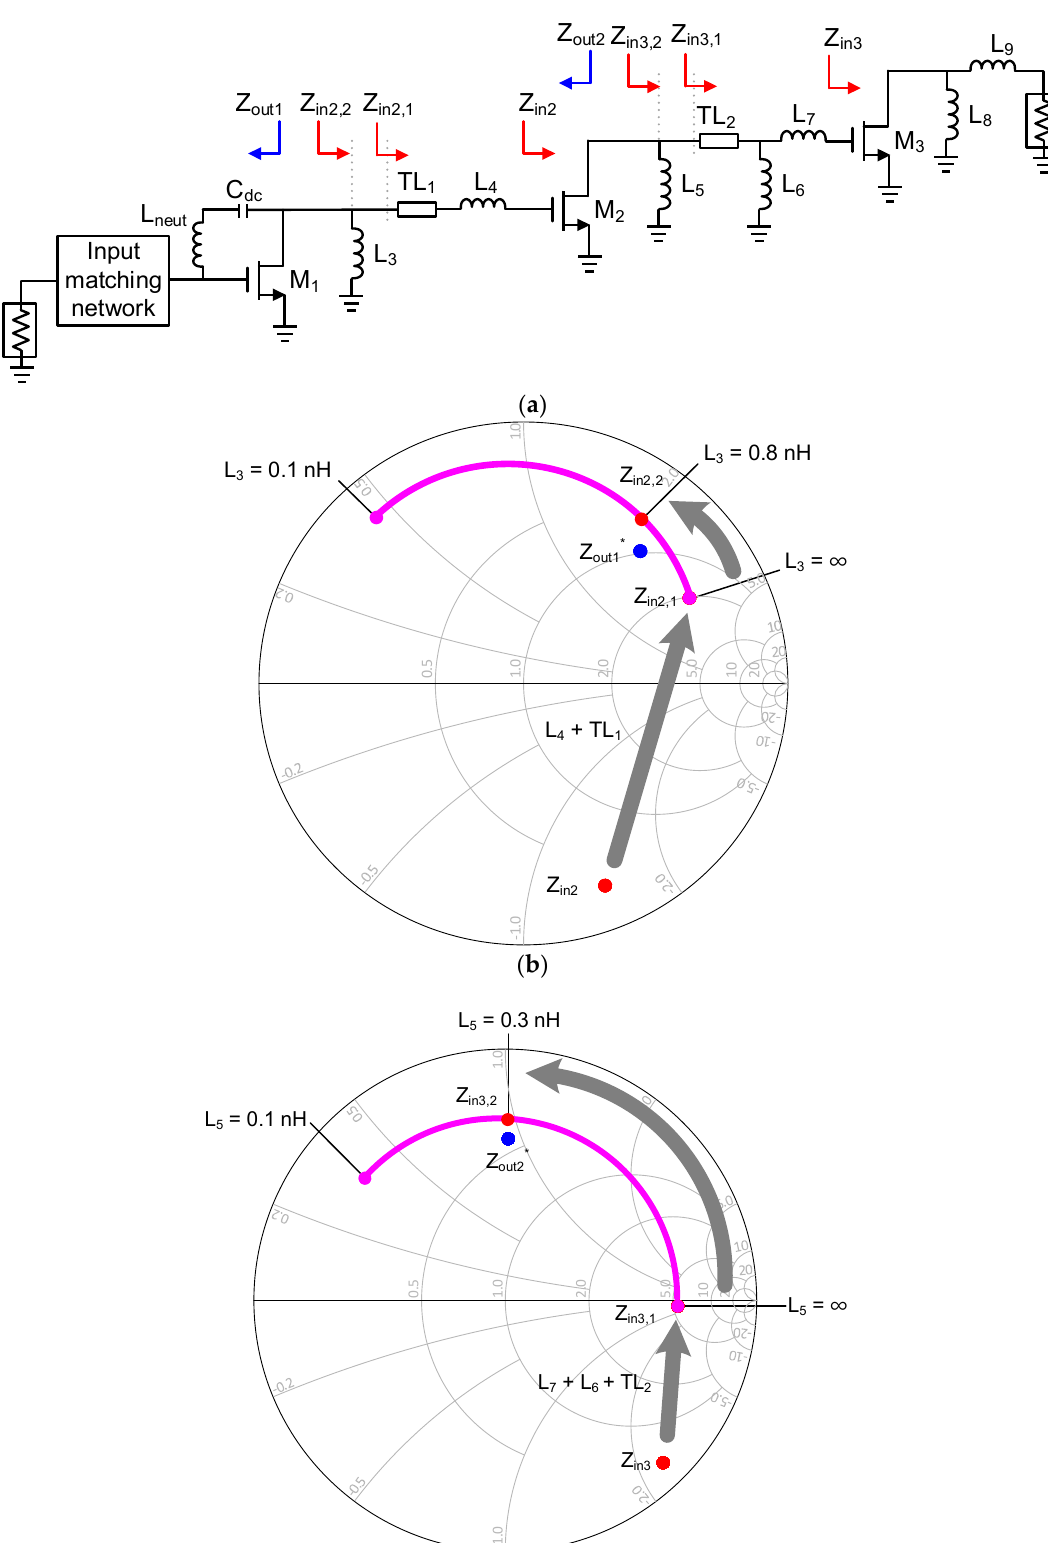
Figure 6. Gain of the three individual stages and the whole amplifier.